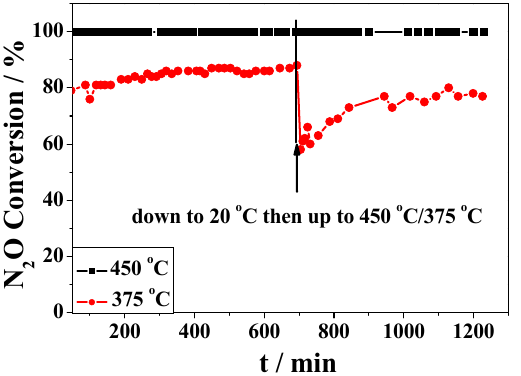
Figure 7. N 2 O conversion versus time-on-stream over Ru/Al 2 O 3 -NaBH 4 catalyst (reaction condition: [N 2 O] = 5000 ppm and gas hourly space velocity (GHSV) = 11,000 h − 1